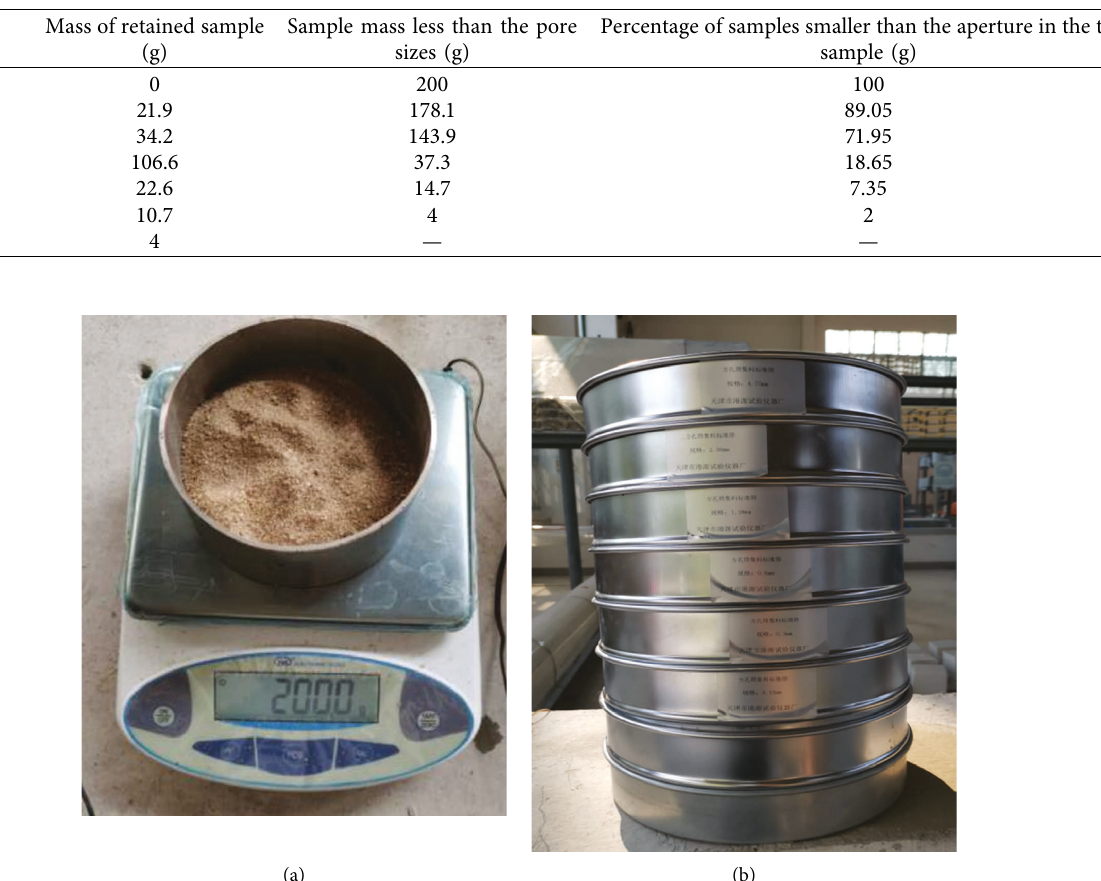
Table 3: Screening results.